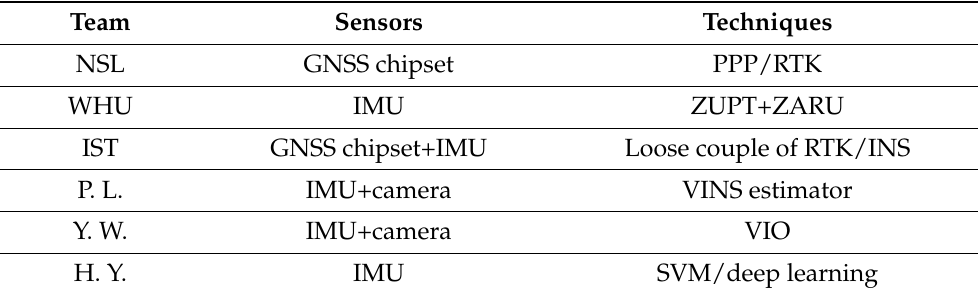
Table 4. Works on smartphone-based positioning